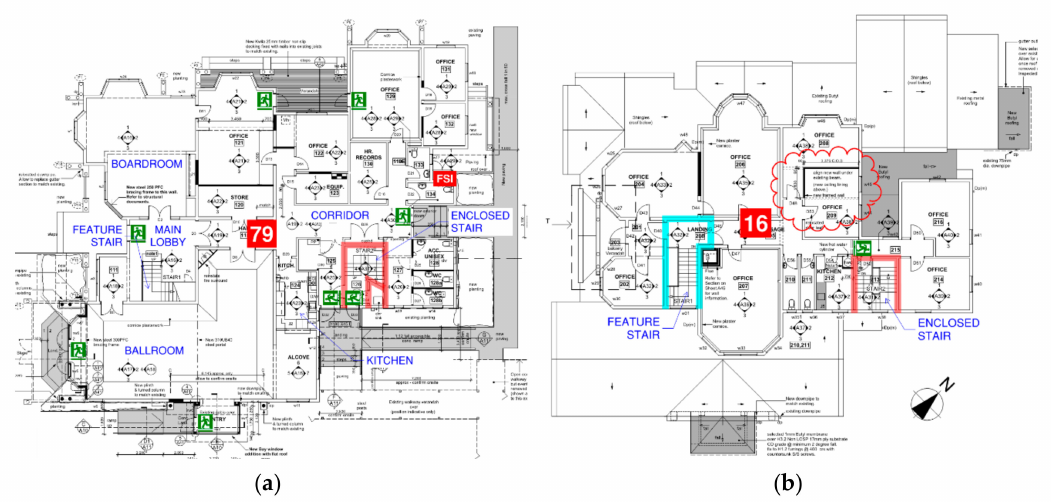
Figure 4. Current layout of McDougall House: ( a ) Ground floor; ( b ) First